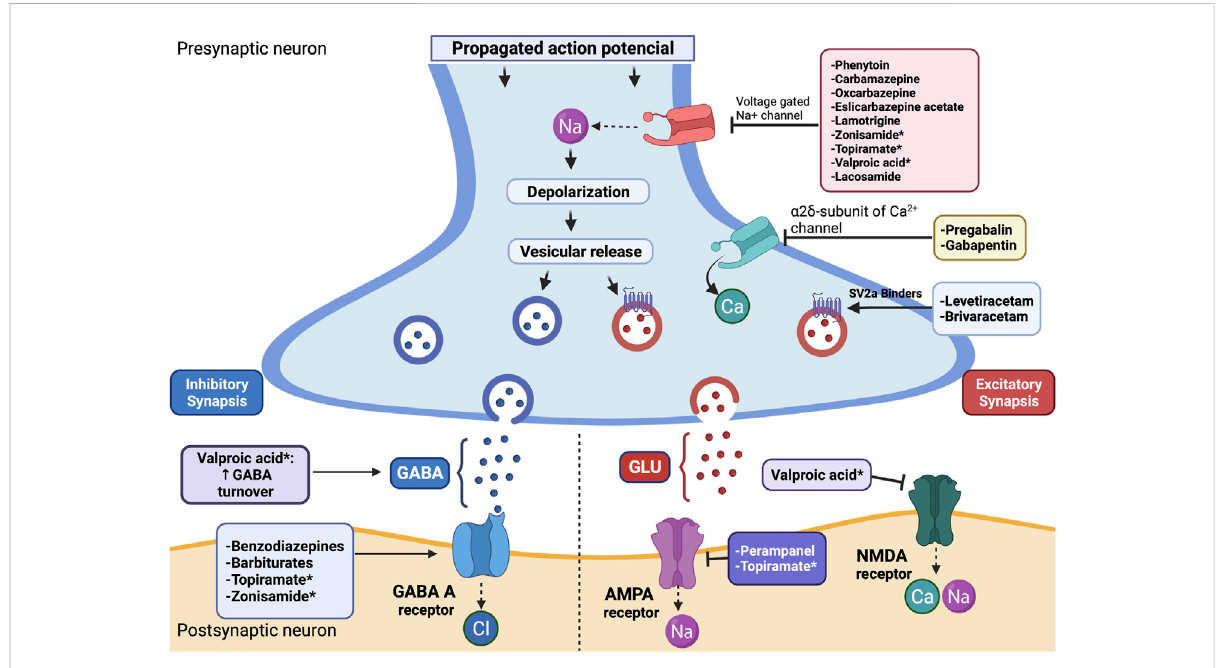
FIGURE 1 Scheme of the mechanism of action of antiseizure medications. *ASM with more than one proposed mechanism of action. Modi fi ed from (Löscher and Klein, 2021). Abbreviations: AMPA, alpha-amino-3-hydroxy-5-methyl-4-isoxazole propionic acid; GABA, gamma-aminobutyric acid; GLU, glutamate; NMDA, N-methyl- D